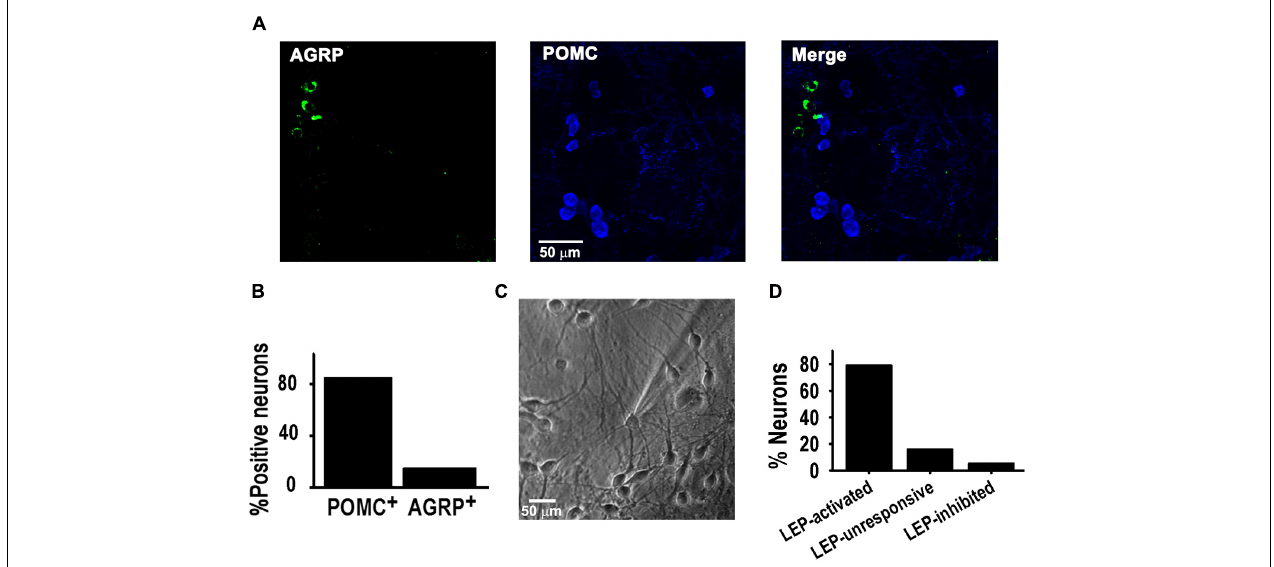
FIGURE 1 | POMC neurons activated by leptin in culture. (A) Example of confocal images showing neurons positive for AGRP (green) or POMC (blue) antibodies in hypothalamus culture at 8–10 DIV. (B) Percentage of neurons positive for AGRP or POMC antibodies ( n = 182). (C) Microscopic image of cultured hypothalamic neuron at 8 DIV. (D) Percentage of WT neurons activated or inhibited by 100 nM leptin ( n = 19), using a 20 pA/s depolarizing ramp stimulus.